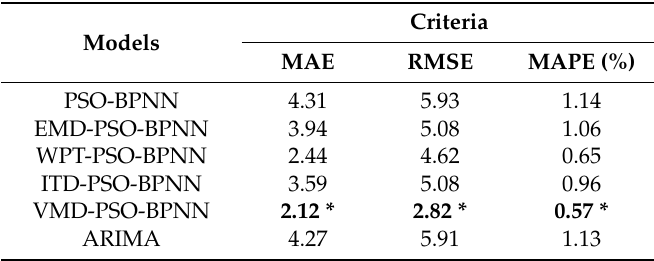
Table 4. Forecasting performance evaluation of